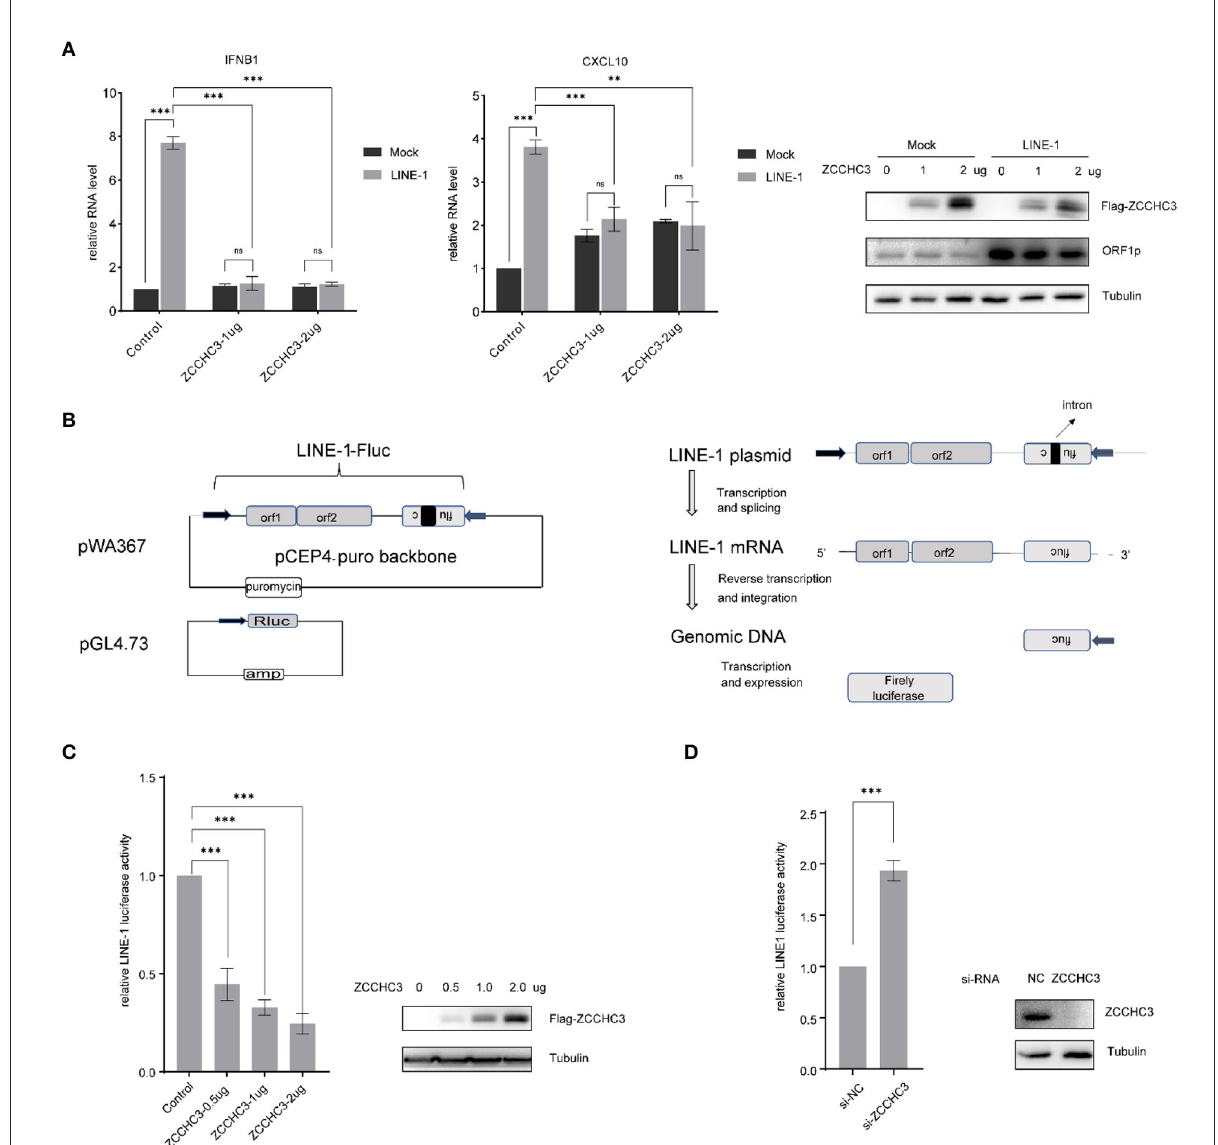
FIGURE1 ZCCHC3 inhibits LINE-1 retrotransposition. (A) ZCCHC3 inhibits LINE-1-induced IFN production. HEK293T cells were transfected with pWA367 and ZCCHC3 DNA. Two days post-transfection, total RNA was extracted for IFNB1 (left panel) and CXCL10 RNA analysis using real-time PCR, and the RNA level was normalized to GAPDH (medial panel). Expression of the LINE-1 ORF1p and Flag-ZCCHC3 were analyzed by immunoblot, and Tubulin was detected as an internal control (right panel). (B) Diagrams of the LINE-1 reporter pWA367 plasmid and Rluc plasmid. pWA367 bears an intron-containing firefly luciferase gene in its 3 ′ UTR. This design ensures that the firefly luciferase will only be produced from the reverse transcribed LINE-1 DNA in the host genome, in which the intron should have been removed during RNA splicing. (C) Overexpression of ZCCHC3 inhibits LINE-1 retrotransposition. HEK293T cells were transfected with pWA367, pGL4.73, and either empty vector or increasing amounts of vector encoding ZCCHC3. Four days post-transfection, cell lysates were analyzed for luminescence activity (left panel). Expression of the Flag-ZCCHC3 was analyzed by immunoblot, and Tubulin was detected as an internal control (right panel). (D) Knockdown of ZCCHC3 increases LINE-1 retrotransposition. HEK293T cells were transfected with pWA367, pGL4.73, and the siRNA targeting ZCCHC3. Four days post-transfection, cell lysates were analyzed for luminescence (left panel). Expression of the ZCCHC3 was analyzed by immunoblot, and Tubulin was detected as an internal control (right panel). Data are representative of at least three independent experiments, values are expressed as means ± SD, and representative blots and images are